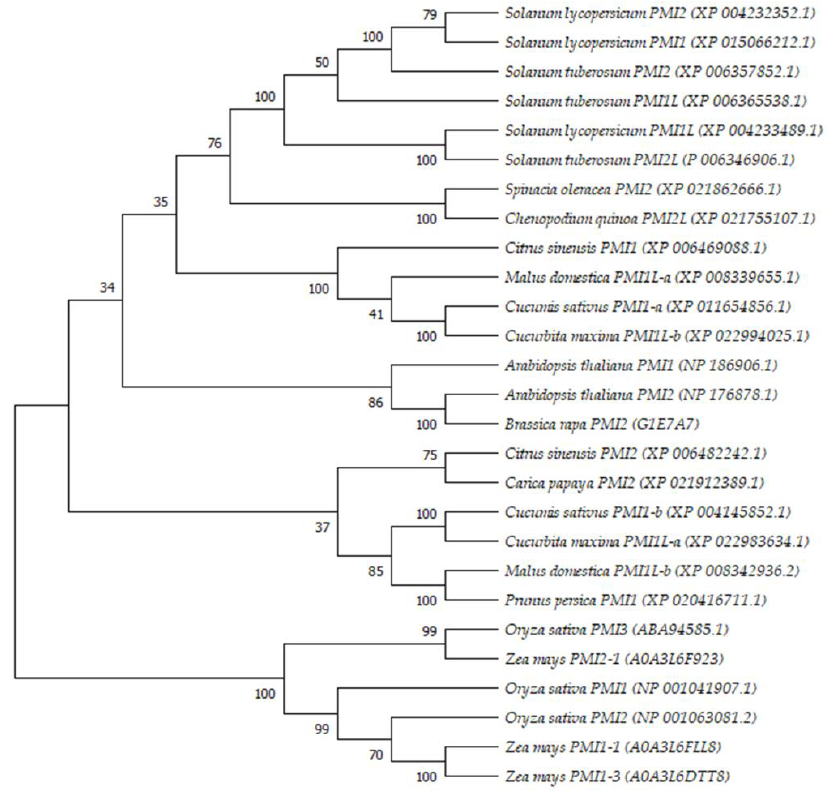
Figure 1. Phylogenetic tree of plant PMIs. MEGA11 was constructed using the Neighbor-Joining method with 1000 bootstrap replicates. The bootstrap support values showing the confidence level are given at the clade nodes as percentages. Other parameters include poisson model, uniform rates, and pairwise deletion. Table 1. The number of transgenics produced using phosphomannose isomerase selection and different combinations of mannose and sucrose in mature Kuharske over six replicates.